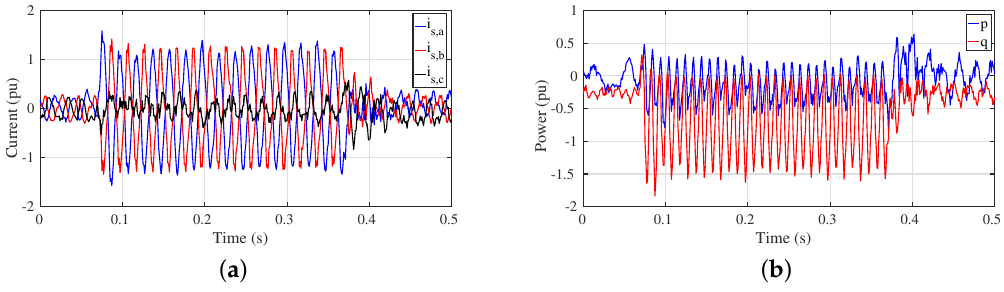
Figure 15. ( a ) Current waveforms and ( b ) instantaneous p and q waveforms for Scenario